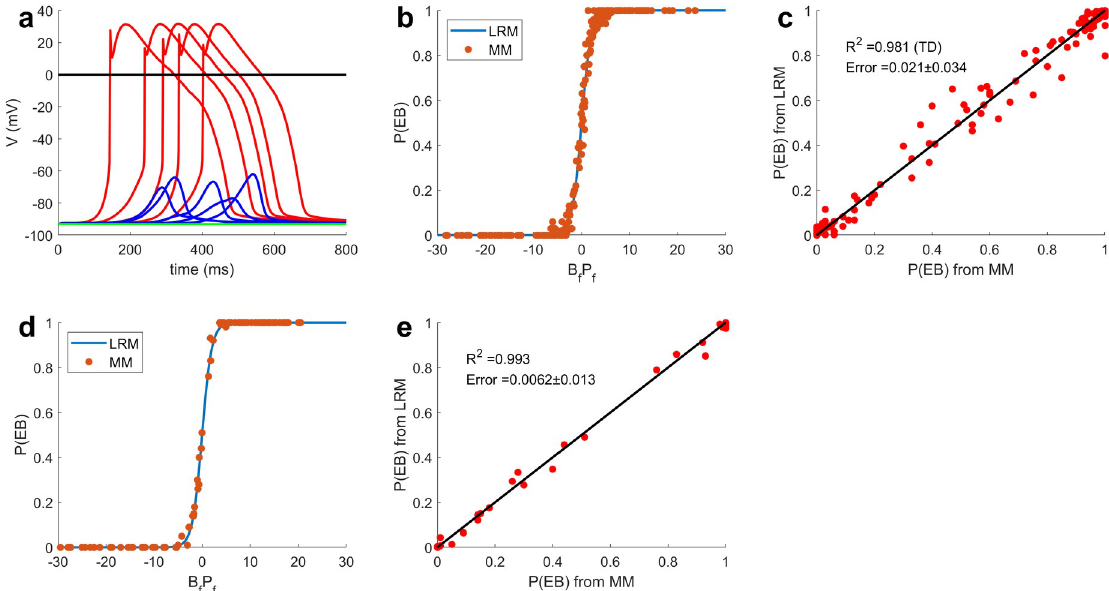
Fig 1. Ectopic beat study. (A) Simulations of ectopic beats (red),simulations that generate DADs without induced ectopic beats (blue) and simulations that exhibit no spontaneous depolarization events (green). (B) Comparison between LRM-predicted P(EB)s (blue) and myocyte model-generated actual P(EB)s (red) as a function of B T P, the argument of the logistic equation (S3 Eq for the training set). (C) Direct comparison between LRM-predicted P(EB)s (y-axis) and myocyte model-generated actual P(EB)s (x-axis) for the training set. (D) and (E) show the same analyses described in (B) and (C), respectively, for the independent test set. R 2 is calculated only from MMI sets within the transition domain, LRM: logistic regression model, MM: myocyte